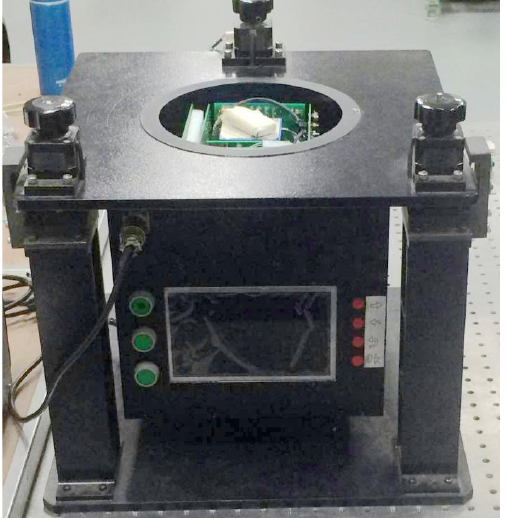
Figure 8. Gyro north finder